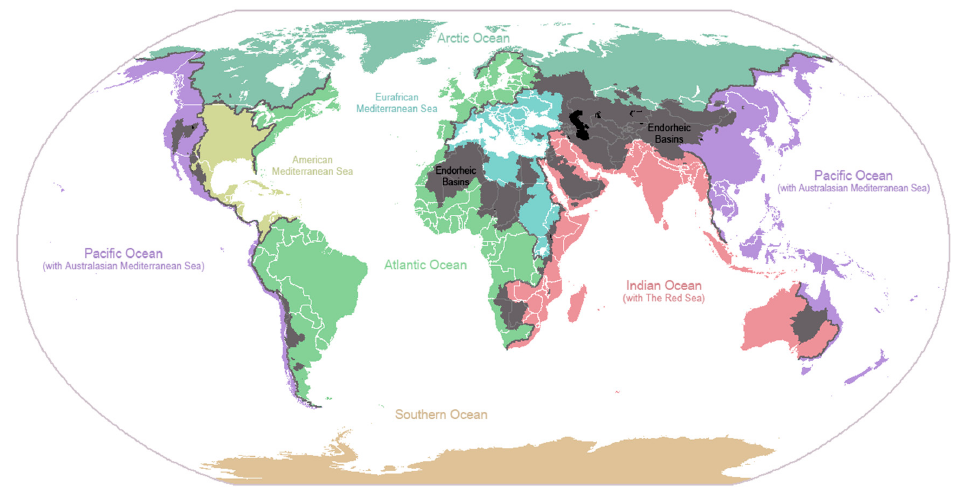
Figure 1. The endorheic basins and related lakes of the world. Dark grey indicates the basins, black are large endorheic lakes. (Source: Smith http://i.imgur.com/Z19wE.png).